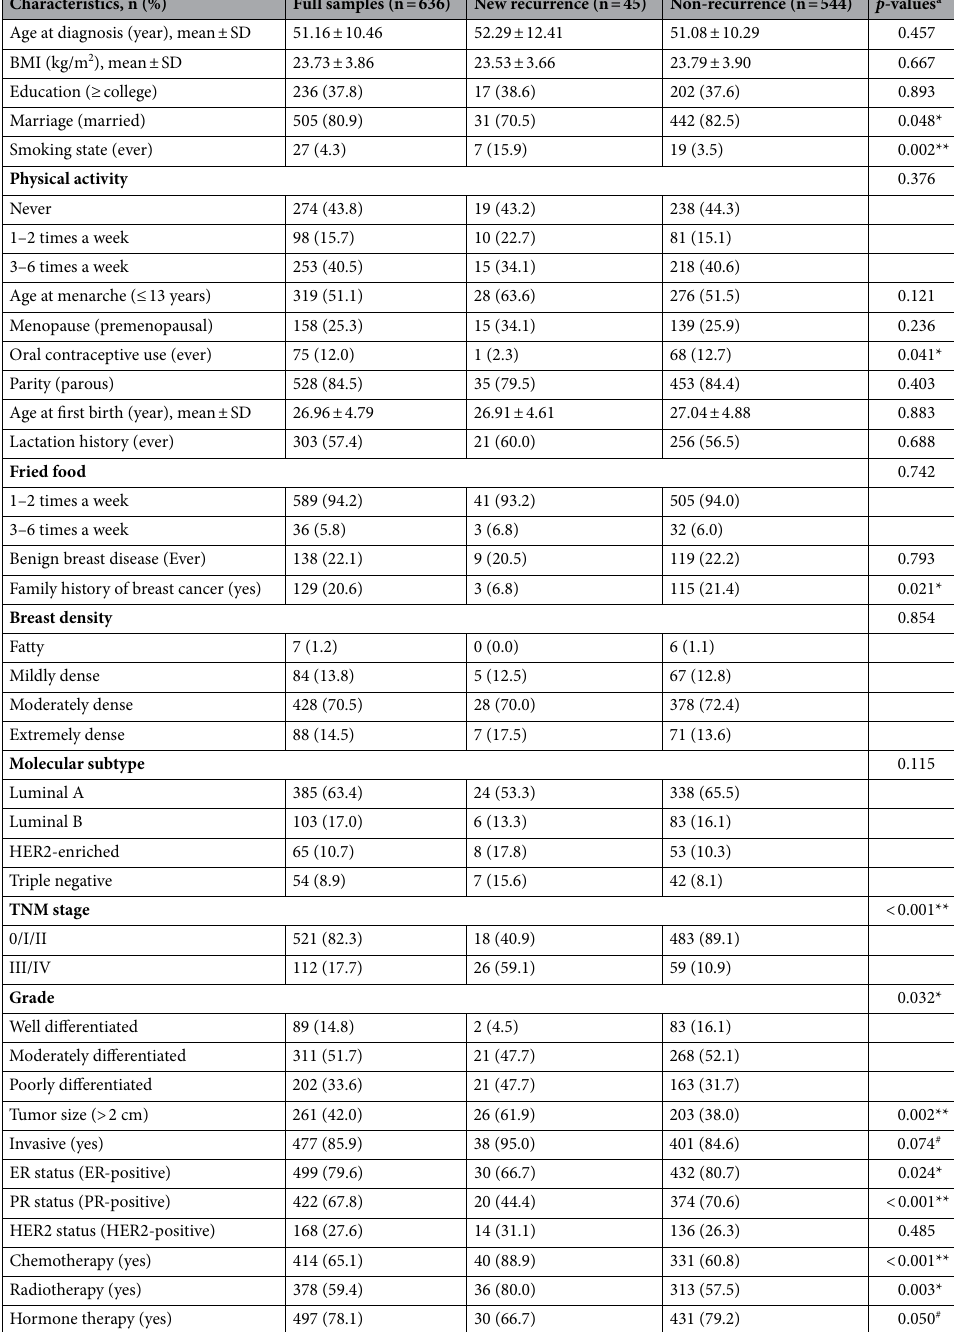
Table 1. The sociodemographic and clinical characteristics of breast cancer patients. SD standard deviation, BMI body mass index, TNM stage TNM classification of malignant tumors, ER estrogen receptor, PR progesterone receptor, HER2 human epidermal growth factor receptor 2. a p- values were calculated for continuous variables by Independent sample t -test and for categorical variables by Chi-square test or Fisher’s exact test. # p- values < 0.1, * p- values < 0.05, ** p- values <